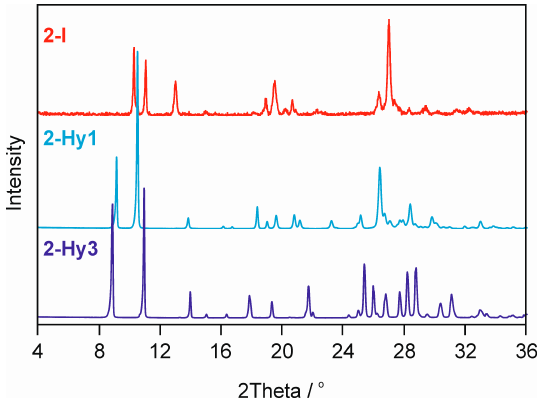
Figure 8. PXRD diffractograms of 2-I , 2-Hy1 and 2-Hy3 .